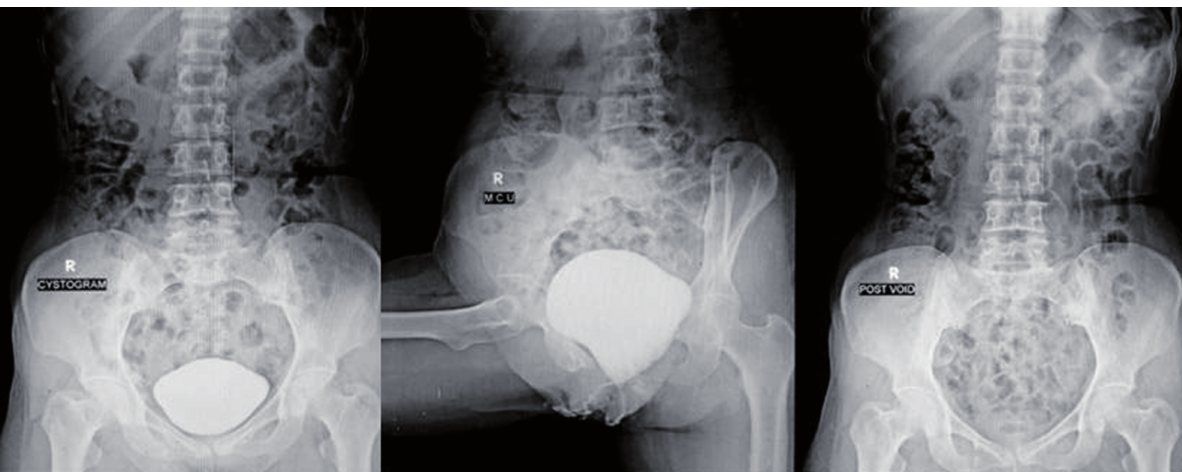
figure 4 - voiding cystourethrogram revealed intact bladder and complete emptying of bladder in post void film with no dye in